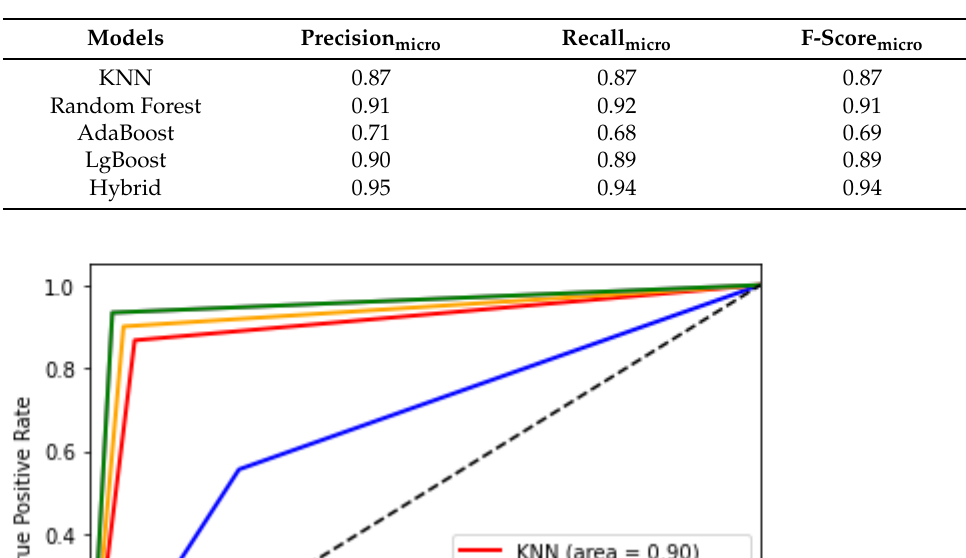
Figure 3. Architecture of predicting users’ academic performance (i.e., high, medium, and low) from mental health and psychological attributes (MP-AP). Table 4. Comparison of different models using performance parameters.